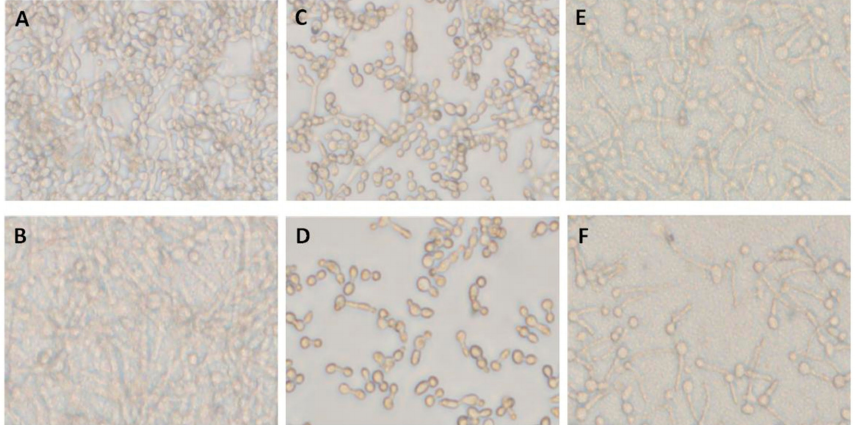
Figure 2. Inhibitory e ff ect of farnesol on single- and mixed-species C. albicans biofilm